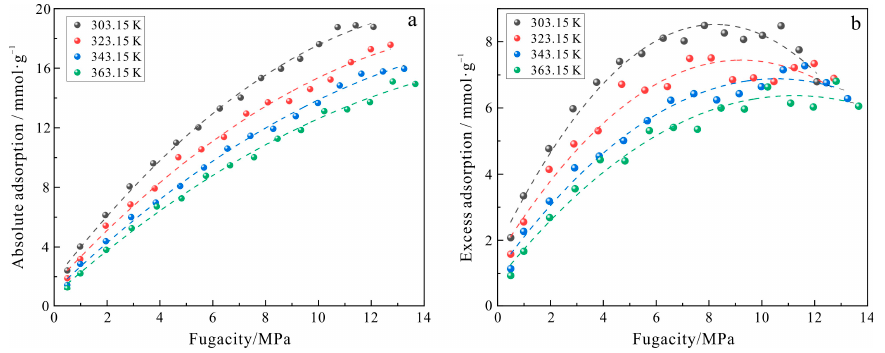
Figure 8. ( a ) The relationship between fugacity and absolute adsorption capacity at different tem- peratures.; ( b ) The relationship between fugacity and excess adsorption capacity at different tem- peratures.